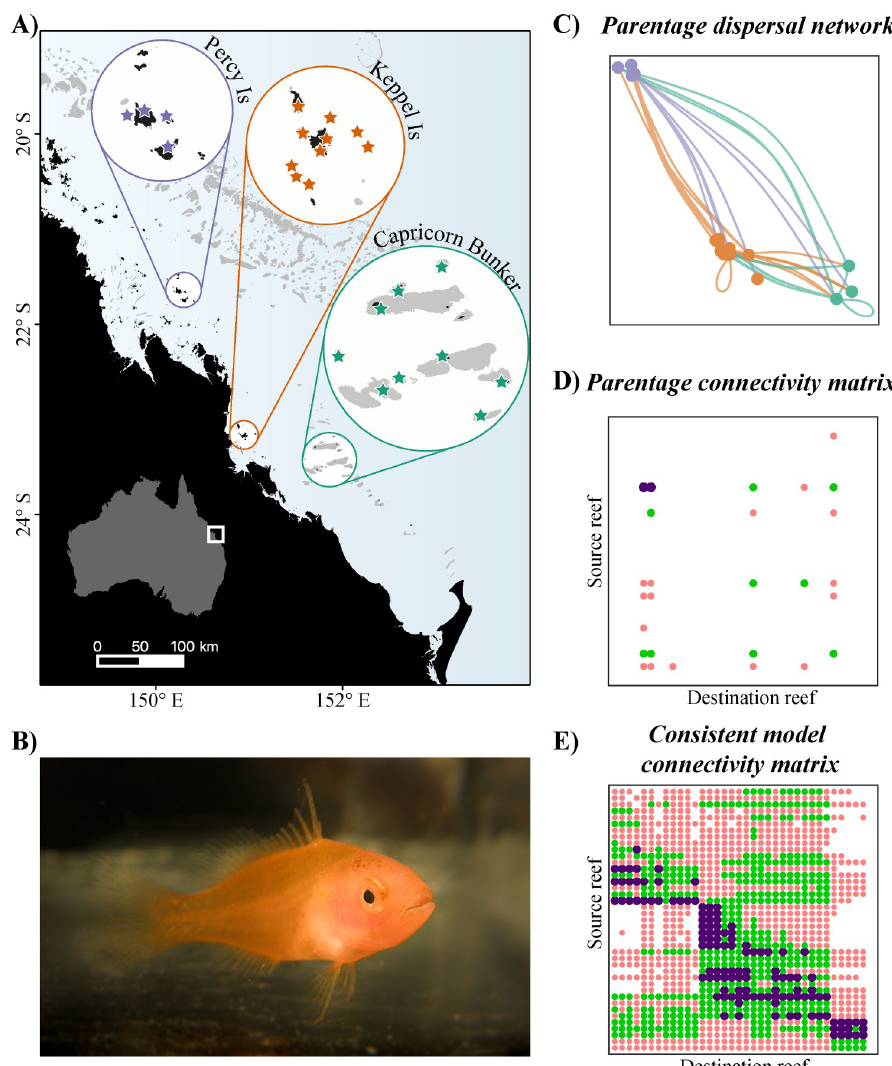
Fig 1. Study region and data. (A) Location of the study region in the southern Great Barrier Reef, Australia. Stars highlight sampled reefs in each region. (B) 16-mm P . maculatus settlement-stage larva. Photo credit : C . Wen . (C) Observed connectivity network between the sampled reefs. Line and reef colours indicate the identity of the source region. Note that bidirectional connections were observed between all three regions. (D) Parentage connectivity matrix for the sampled reefs. Only a few rows and columns contain connections, because only a subset of reefs were sampled. (E) Connectivity matrix generated by the consistent biophysical model simulations, for all reefs in the three regions. Each row and column correspond to a reef in one of the three sampled regions. In both matrices, colours indicate the relative strength of dispersal, with purple > green > red. Biophysical simulations give a more complete picture of regional dispersal patterns, but the genetic parentage data are empirically defensible. The data used in this figure are given in S1 Data. Is, Islands.